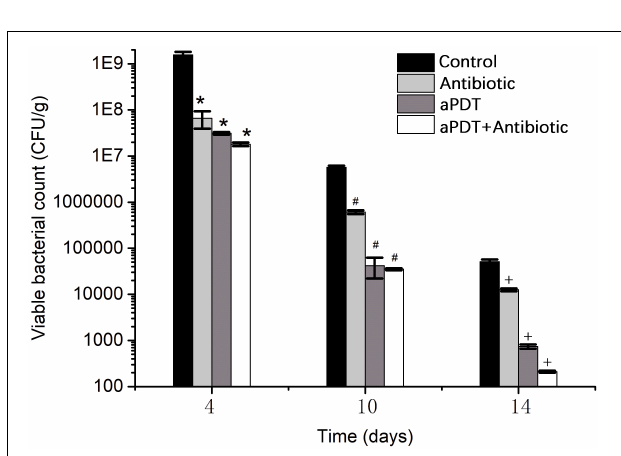
FIGURE 8 | The viability of bacteria in burn wound tissue of rats in each group on the 4th, 10th, and 14th day post-infection [* p < 0.05 vs. control group (4 days); # p < 0.05 vs. control group (10 days); + p < 0.05 vs. control group (14 days)].